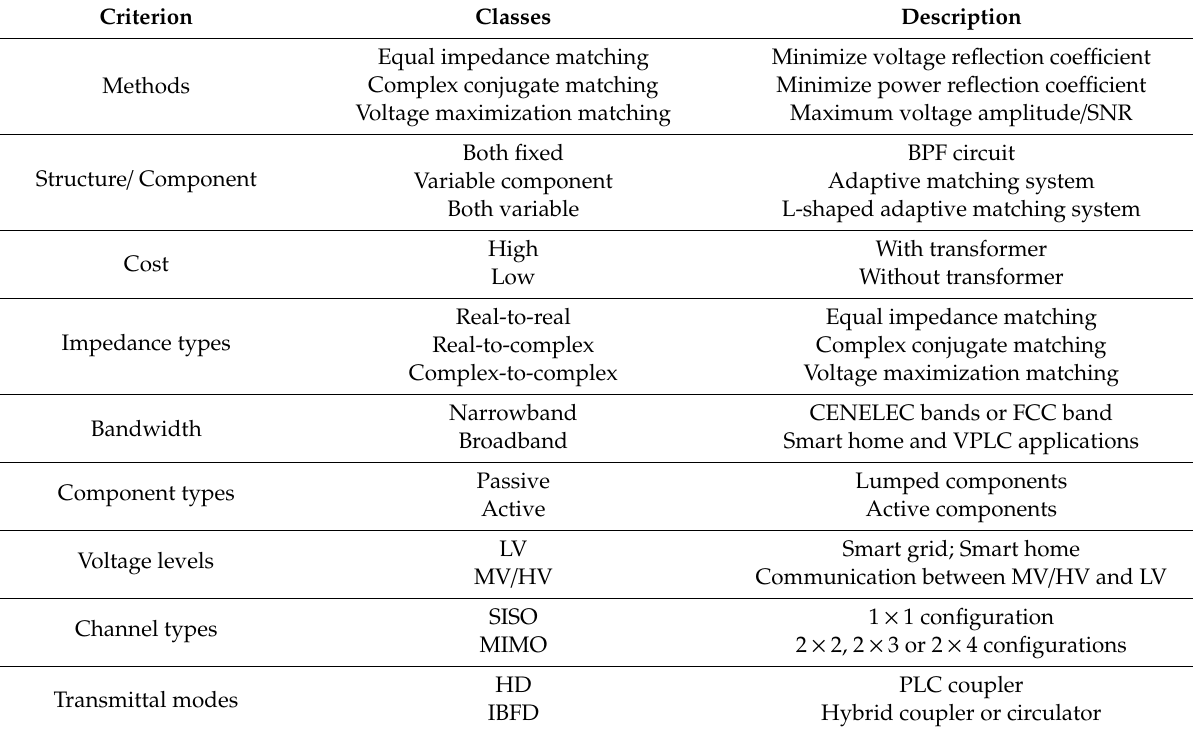
Table 3. Classification methods for PLC impedance matching